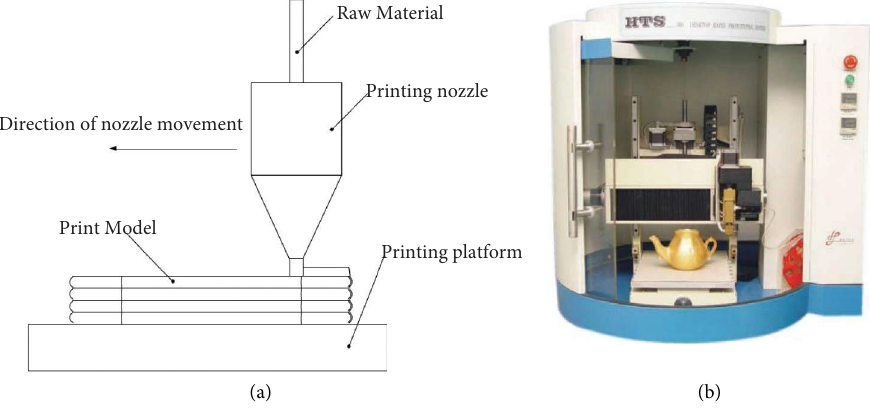
Figure 2: FDM printing principle (a) and equipment (b).